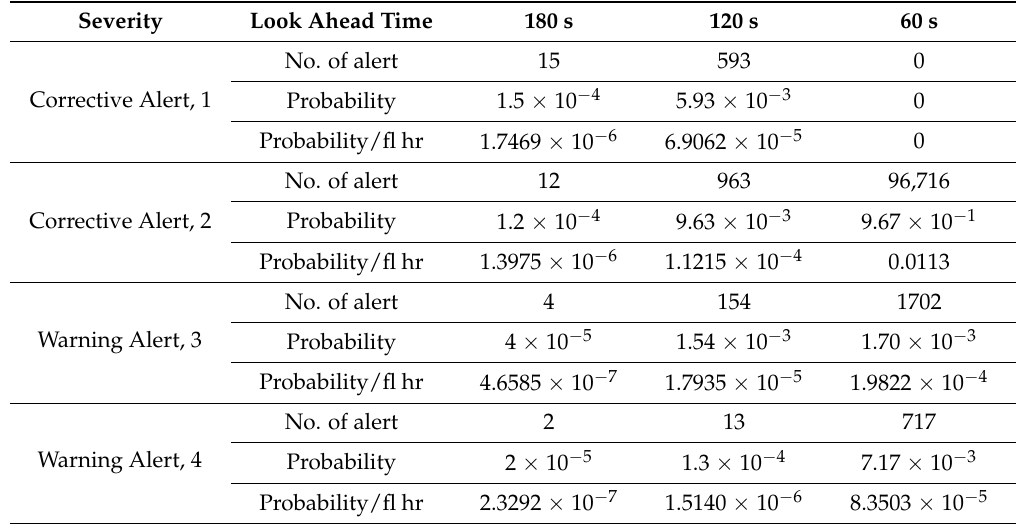
Table 17. Alert probability summary, overtaking